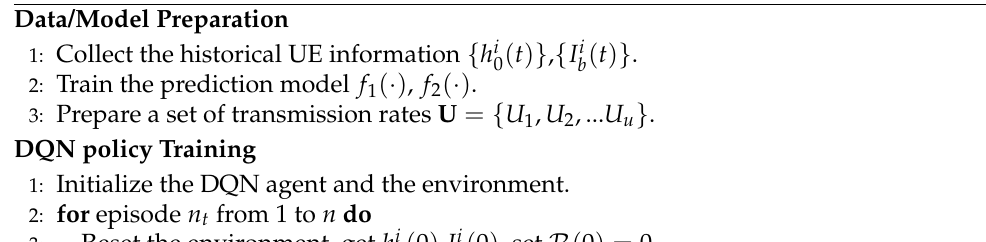
Algorithm 1 DQN-based joint sub-channel allocation and transmission rate selection Data/Model